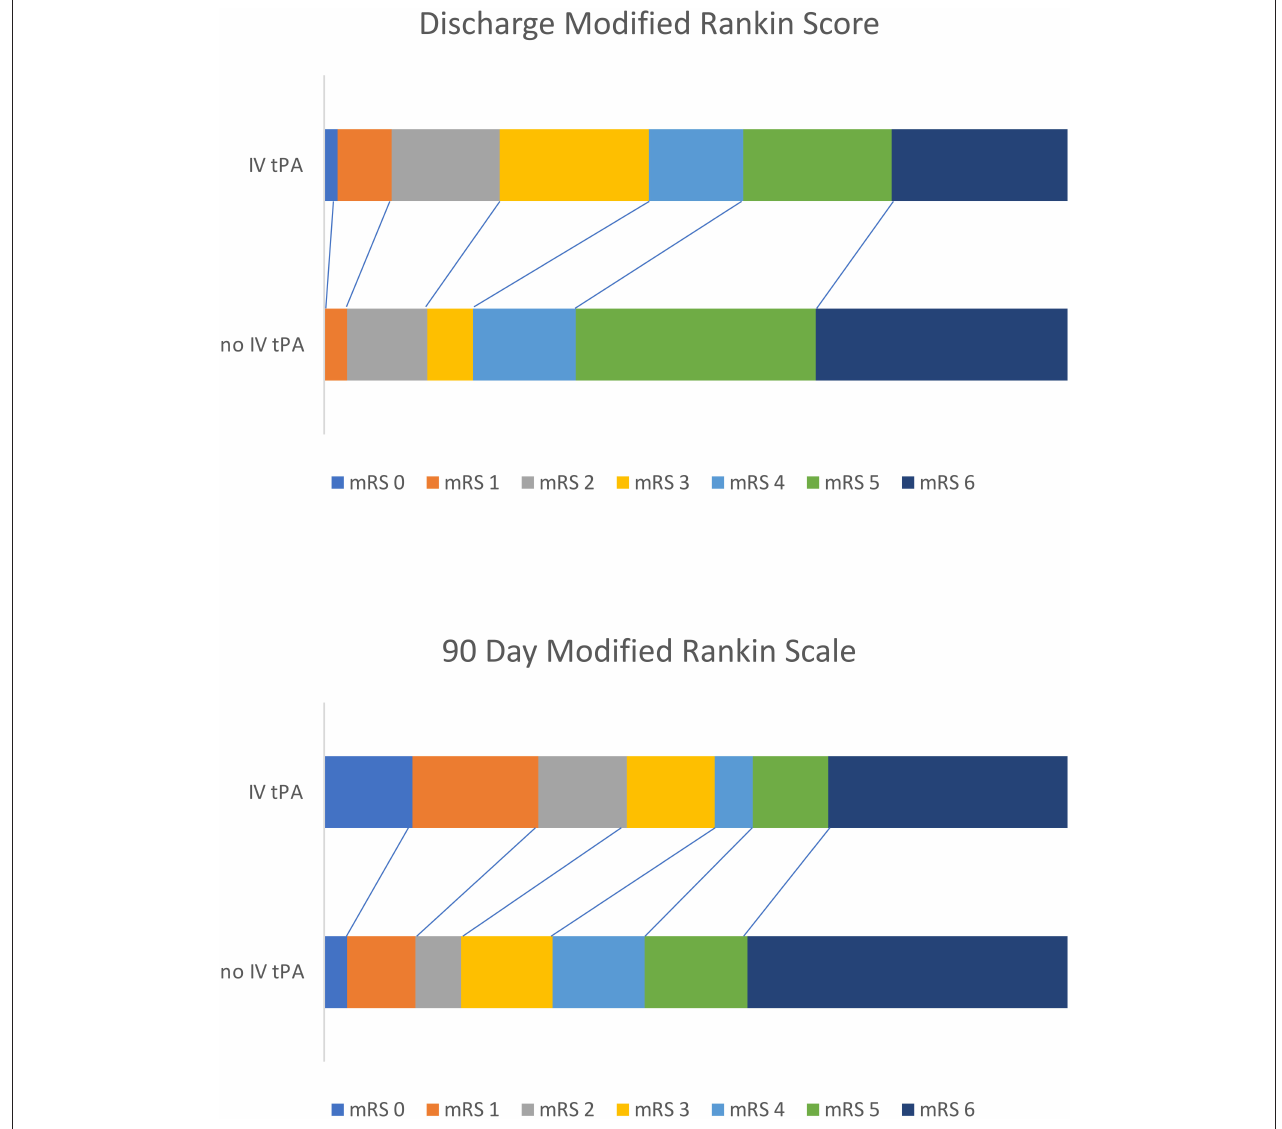
FIGURE 1 | Rankin shift illustrating improved outcomes for those bridged with IV tPA before mechanical thrombectomy at both discharge and 90 days